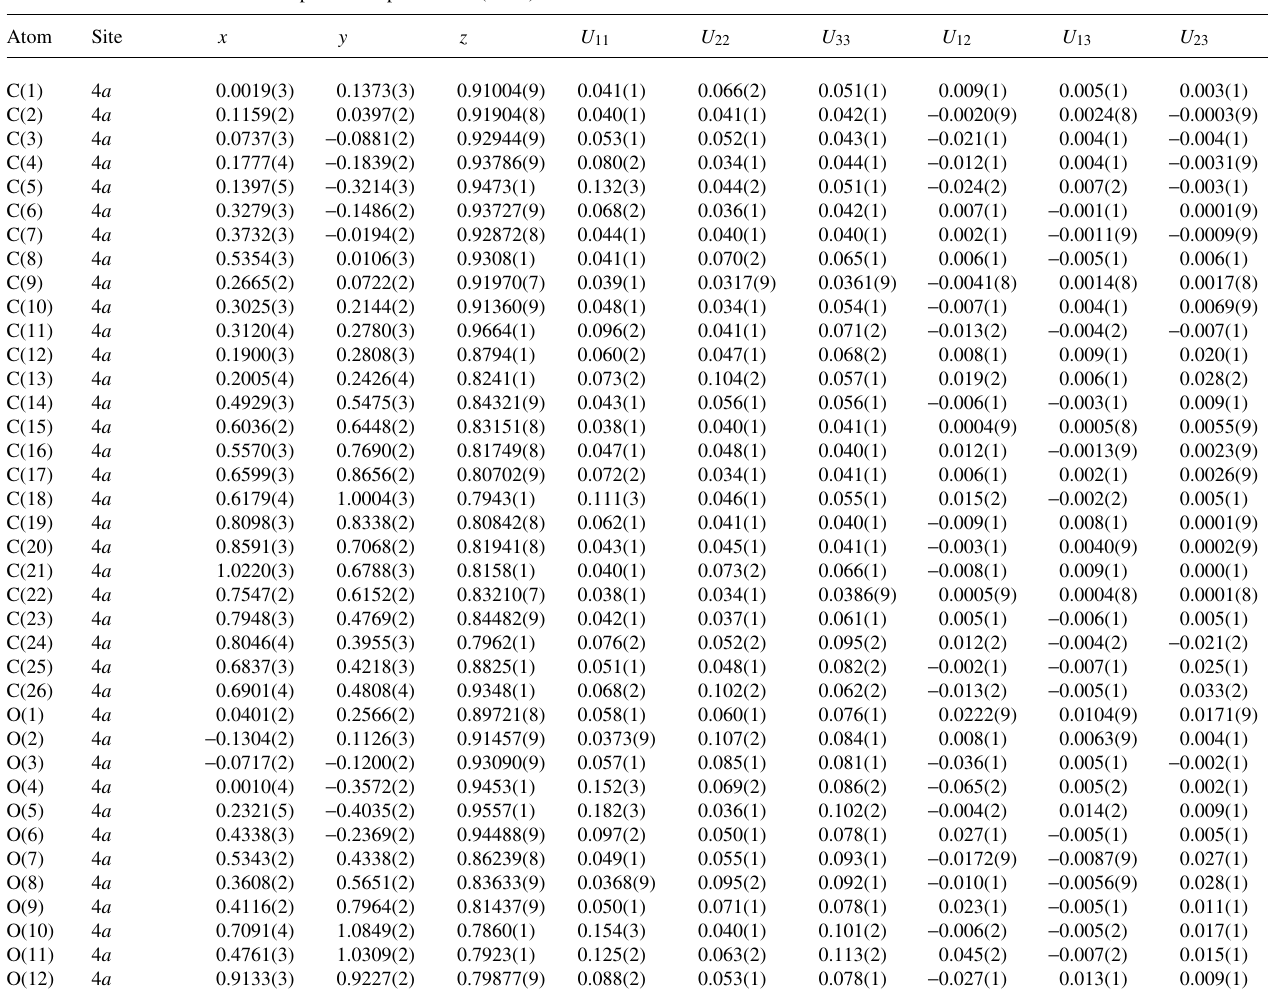
Table 3. Atomic coordinates and displacement parameters (in Å 2 ) .